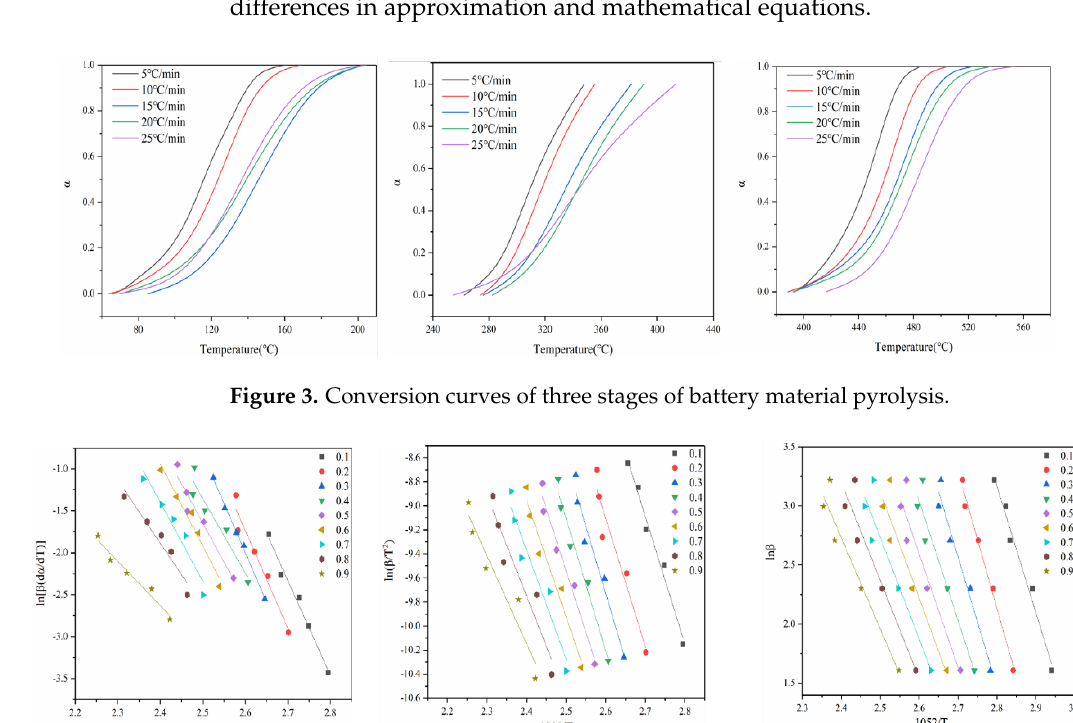
Figure 4. Conversion curve of the first stage of battery material pyrolysis.